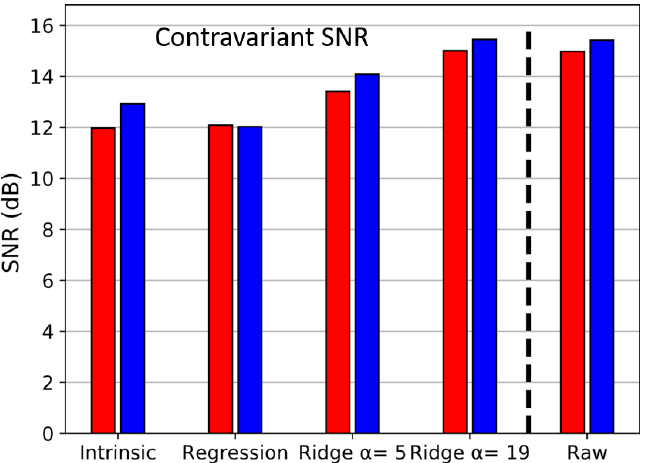
Figure 15. Contravariant signal to noise ratio (SNR) corresponding to several reconstructing methods for over red and blue channel (colors of the